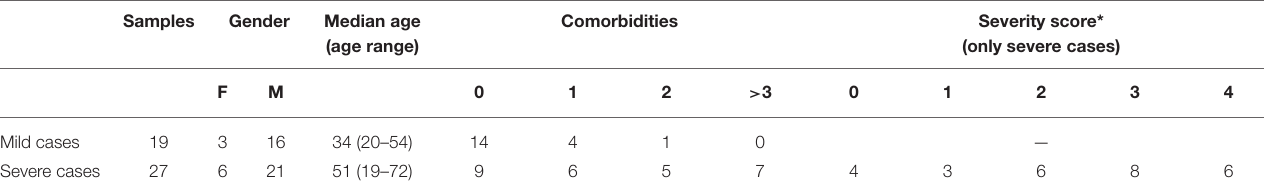
TABLE 1 | Summary of the main demographic and clinical characteristics of COVID-19 patients included in this study.